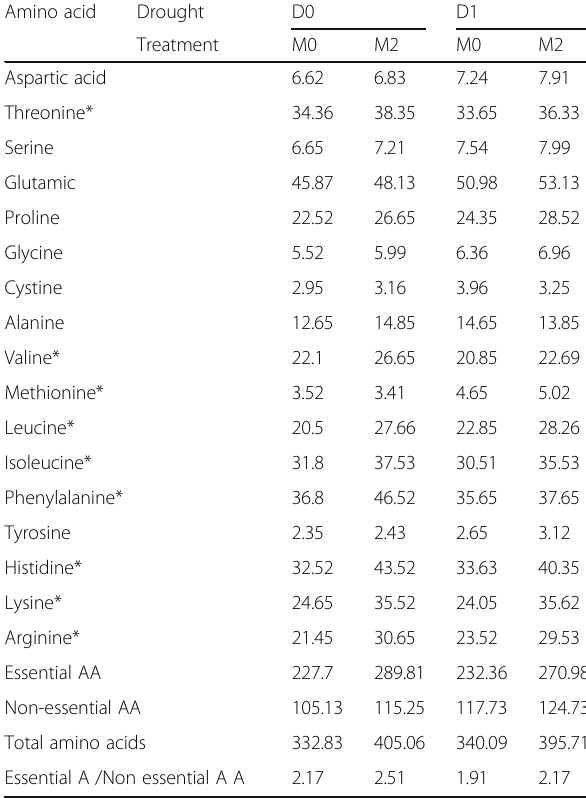
Table 4 Effect of melatonin (0 and 100 mM) on amino acid composition of M. oleifera plants subjected to drought stress (normal irrigation and skipping two irrigation